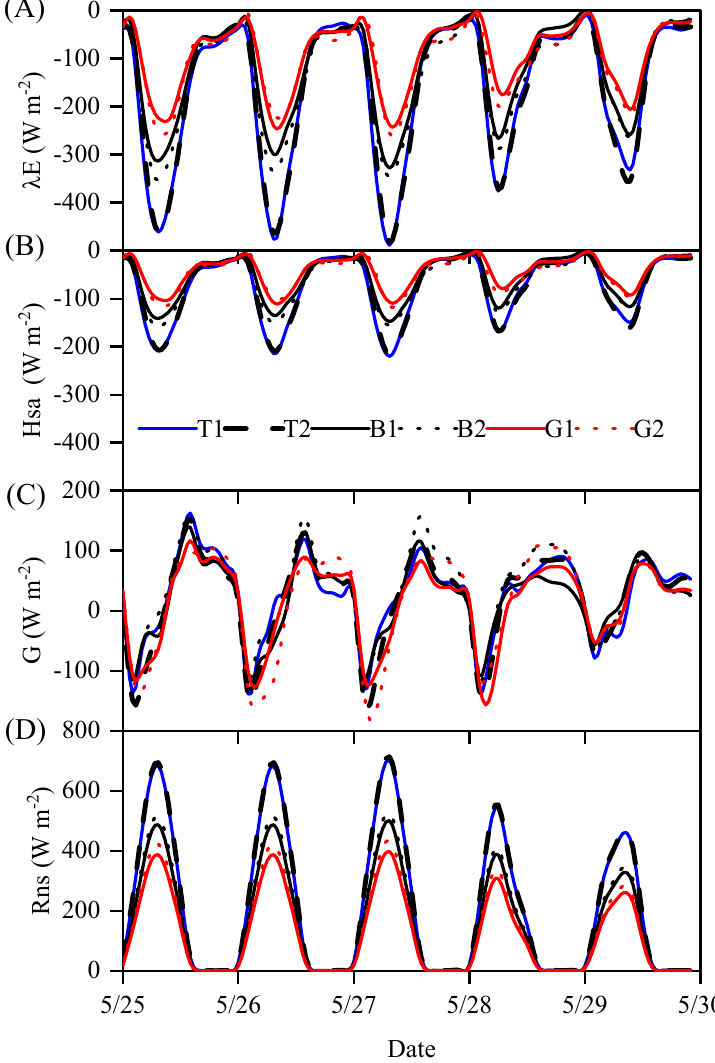
Figure 13. Comparisons of the different components: ( A ) the latent heat flux between the soil surface and atmosphere ( λ E ); ( B ) the air sensible heat flux between the soil surface and the atmosphere ( H sa ); ( C ) the heat flux downward through the soil surface ( G ); ( D ) the net radiation at the soil surface ( R ns ).